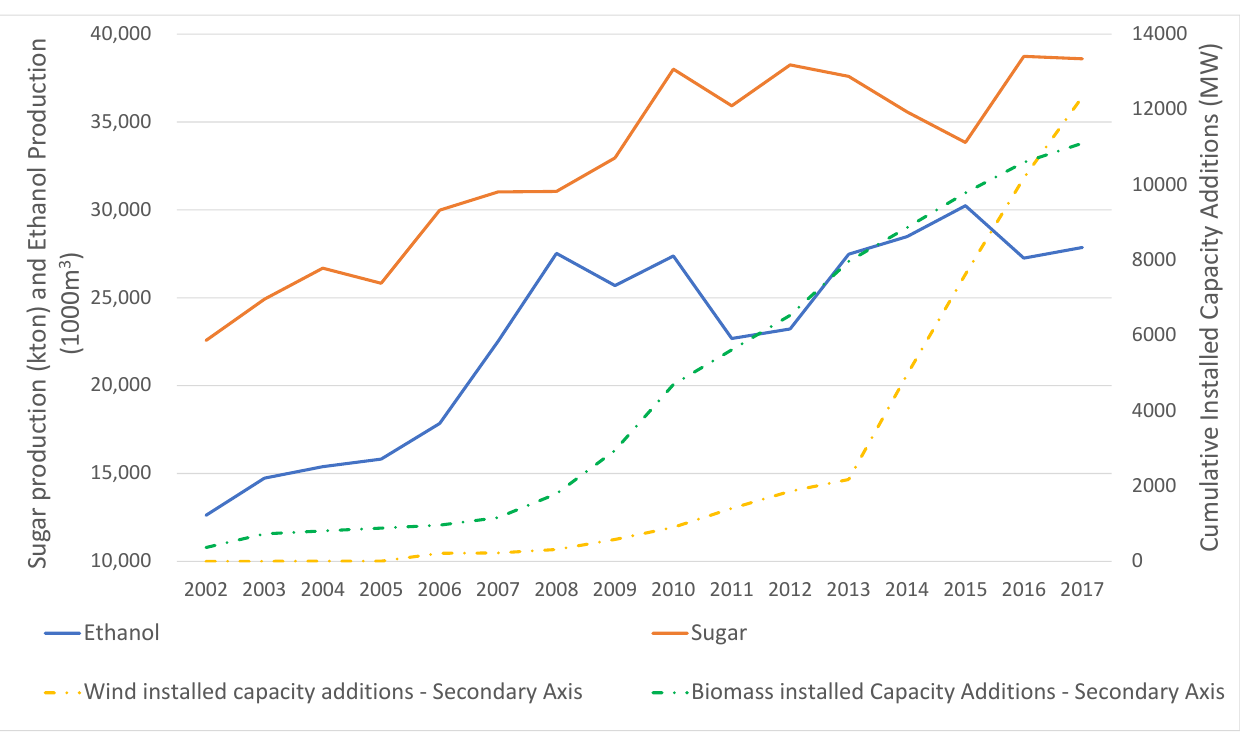
Figure 8. Sugar and ethanol production and cumulative capacity additions from 2002 to 2017 Based on [64,83].